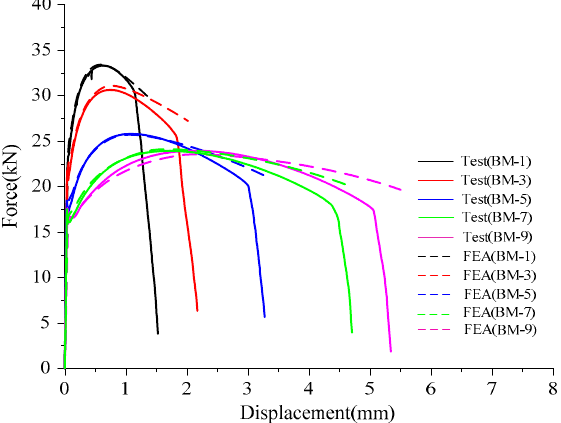
Figure 6. Comparison of force-displacement obtained by tests and FEA under tensile loading. Table 3. Calibration results of monotonic void growth capacity.